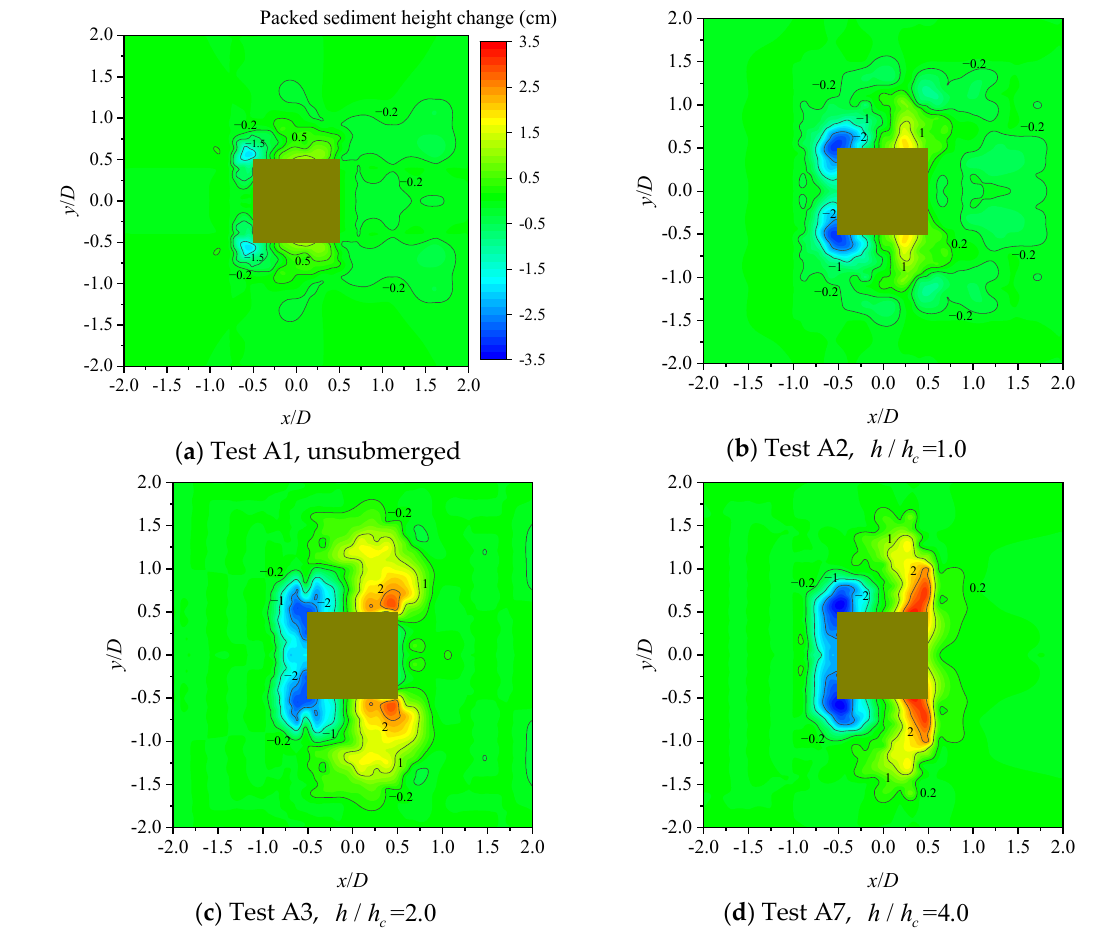
Figure 3. Equilibrium state of topographies of Tests A1, A2, A3, and A7. With the increasing flow depth, the two separate scour holes upstream extended from upstream corners to the upstream symmetry center line gradually and the scour depth at K C became deeper simultaneously. These phenomena reflect that both of the depths and sizes of scour holes were governed by the flow accelerations in submerged square